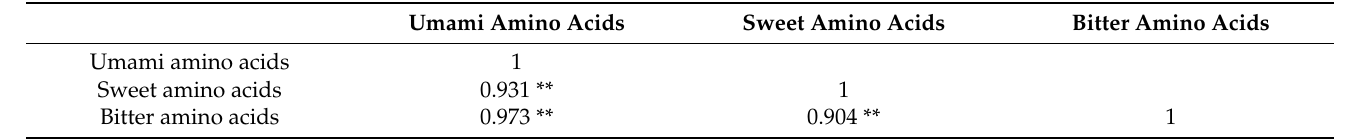
Table 13. Correlation analysis of flavor amino